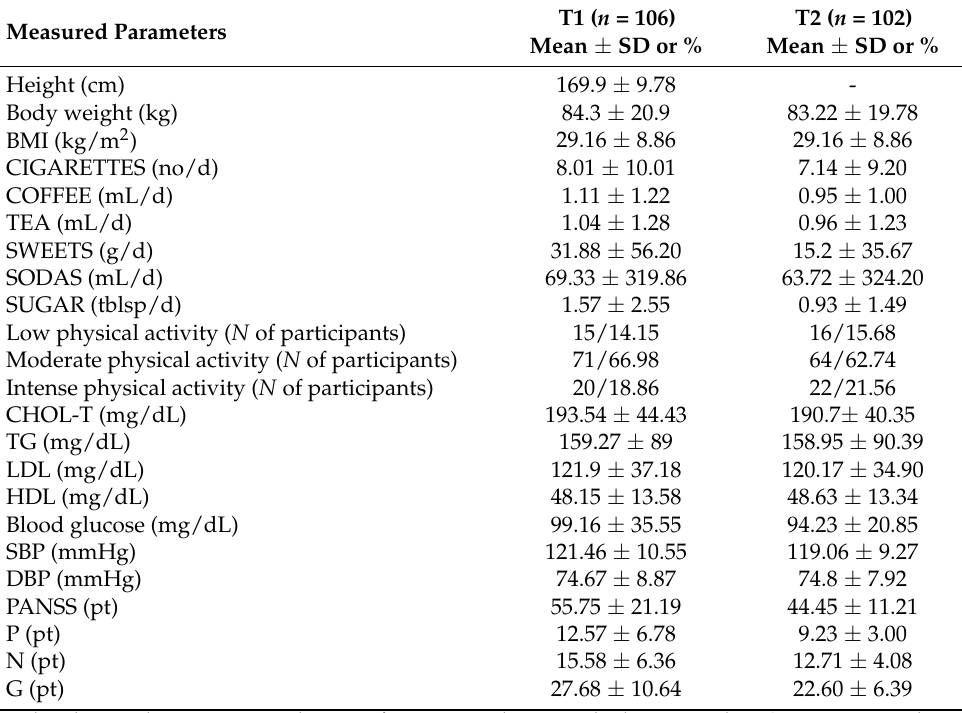
Table 1. Study participants clinical characteristics at baseline ( n = 106) and after follow-up of 8–10 weeks ( n =